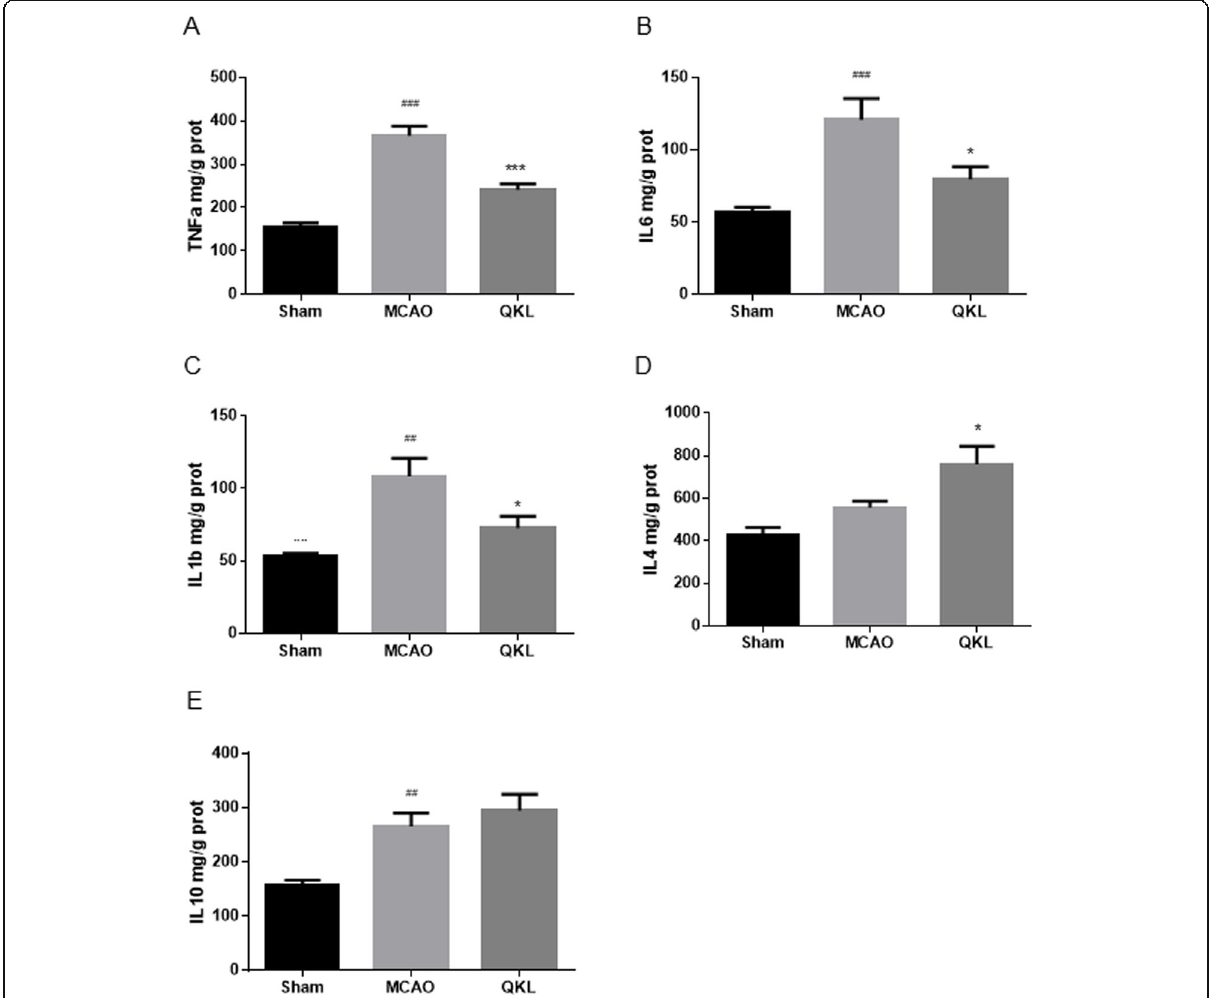
Fig. 4 Analysis of the expression of pro-inflammatory cytokines, TNF- α , IL-6 and IL-1 β , and anti-inflammatory cytokines, IL-4 and IL-10. a - c analysis of pro-inflammatory cytokines using enzyme-linked immunosorbent assay (ELISA) method for TNF- α , IL-6 and IL-1 β , respectively. d - e analysis of anti-inflammatory cytokines using the ELISA method for IL-4 and IL-10, respectively. Data points indicate means ± SEM. Vs Sham group, ## < 0.01, ### < 0.001, Vs MCAO group, * p < 0.05, *** p < 0.001. At least three independent experiments were performed for each